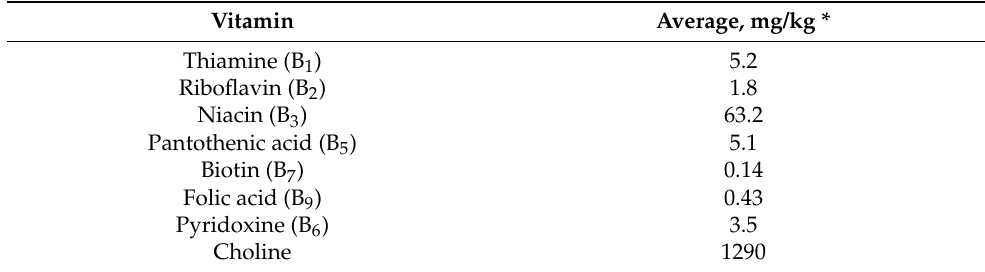
Table 3. The proportion of B-complex vitamins in barley (Adapted with permission from Ref. [9] 2022, John Wiley and